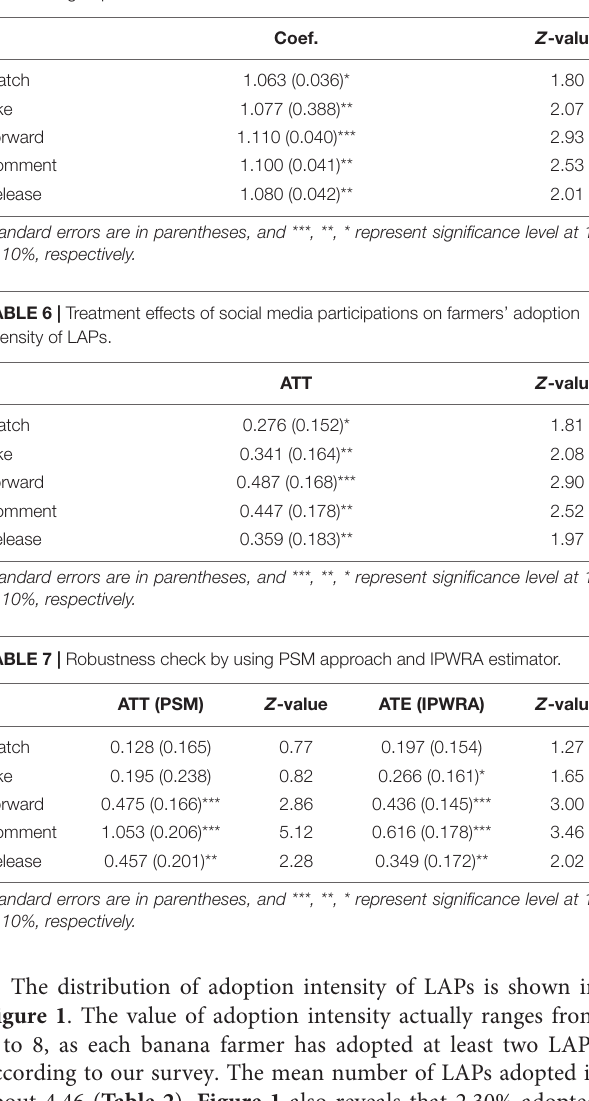
TABLE 5 | The ratio of adoption intensity in the treated group to that in the control group.